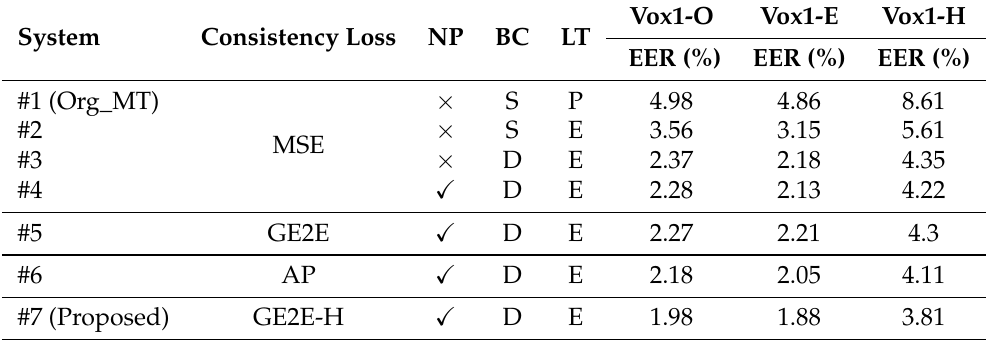
Table 4. Comparison and ablation experiment results of the proposed method. NP: negative pair, BC: batch configuration, S: same batch, D: different batch, LT: learning target, P: prediction, E: